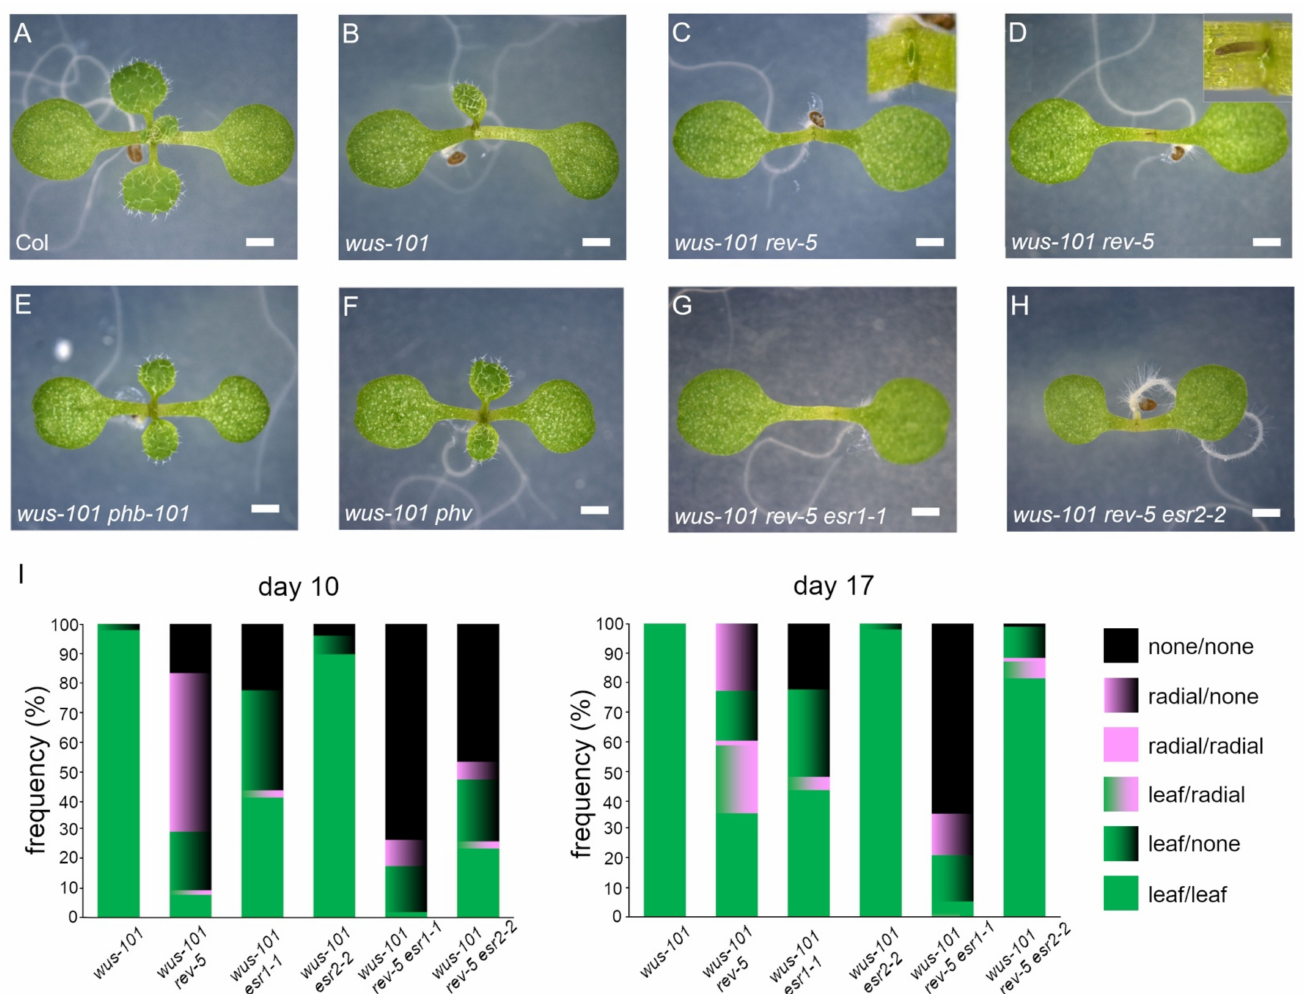
Figure 2. rev-5 but not phb-101 or phv enhances wus phenotype. ( A ) Five-day-old Col-0; ( B ) wus-101 ; ( C,D ) wus-101 rev-5 , note the radial structure (inset) in ( D ); ( E ) wus-101 phb-101 ; ( F ) wus-101 phv ; ( G ) wus-101 rev-5 esr1-1 ; ( H ) wus-101 rev-5 esr2-2 ; ( I ) frequency of phenotypes in the respective mutant background on 10 d.a.g (left) and 17 d.a.g. (right). At least 50 individual plants per genotype were examined with biological triplicates. The first pair of emerged rosette leaves are categorized into a developed leaf (green) or radial structure (pink). Black indicates no development of lateral organs at the indicated time